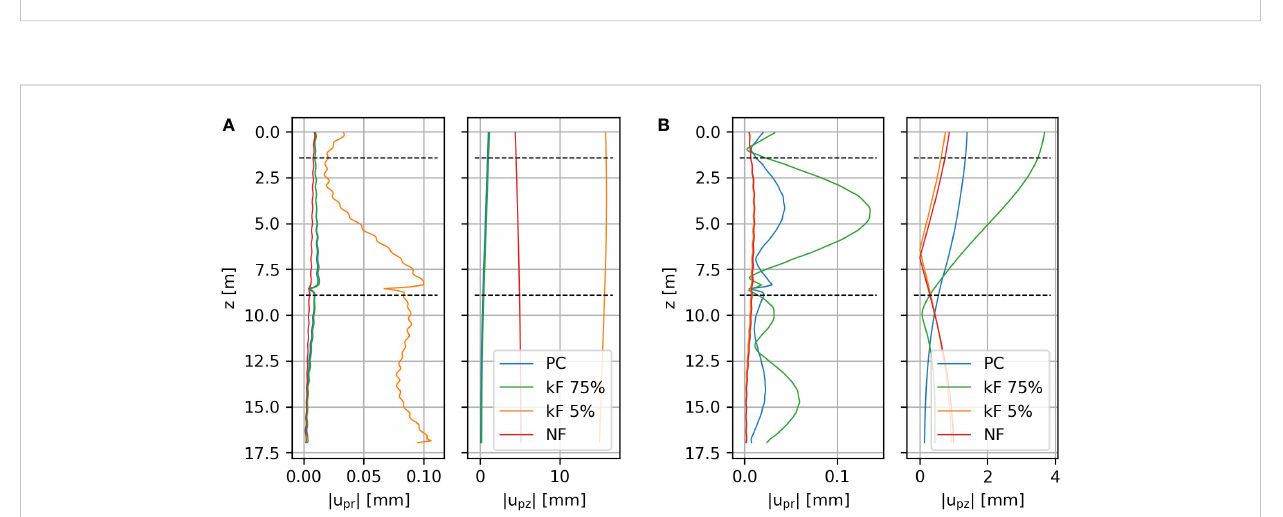
FIGURE 5 The amplitudes of the pile displacements in radial ( u pr ) and vertical ( u pz ) direction for a 1 MN harmonic force on top of the pile at 25 Hz and 125 Hz in (A, B) ,